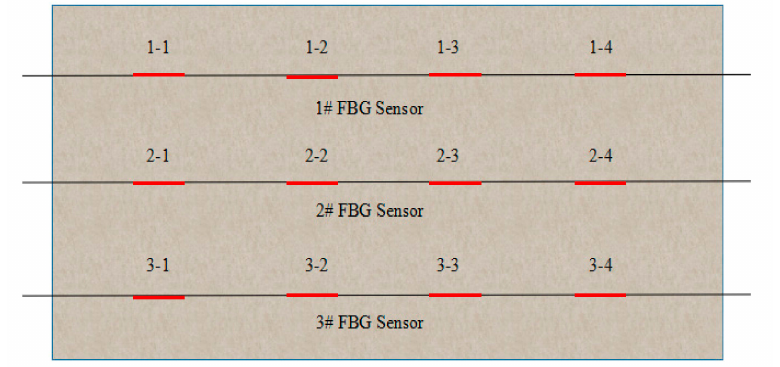
Figure 7. Schematic diagram of the measurement point of FBG temperature